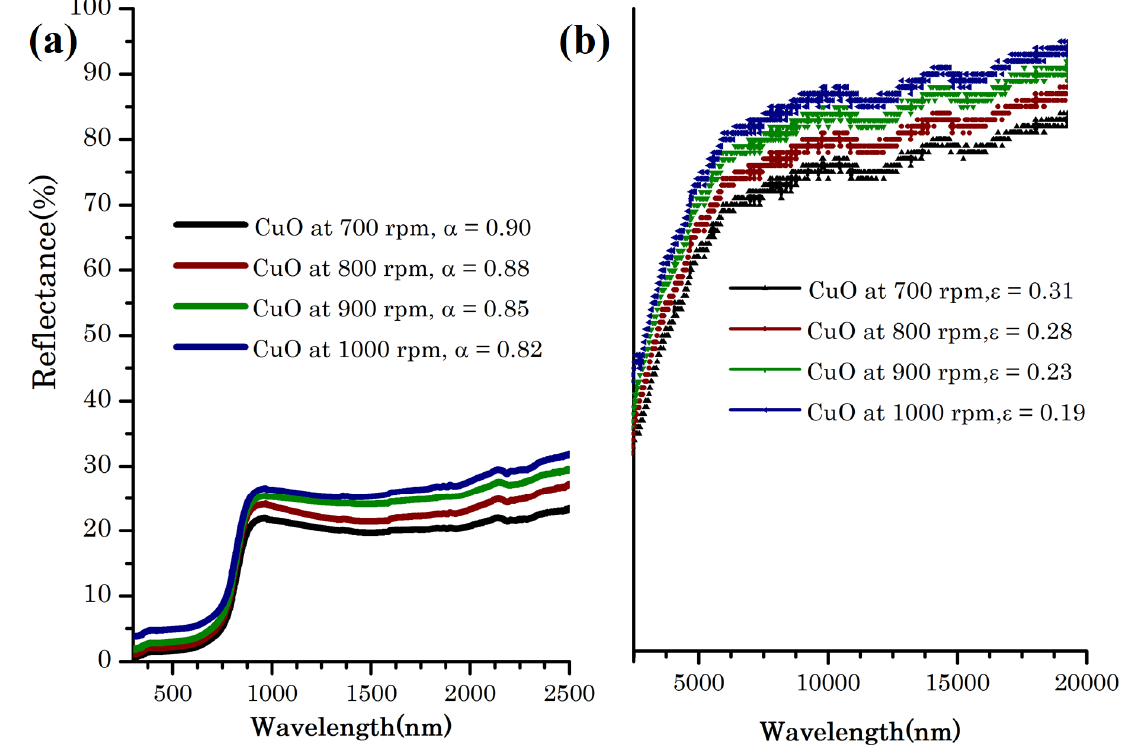
Figure 10. Reflectance spectra of CuO ( a ) Solar region ( b ) FTIR